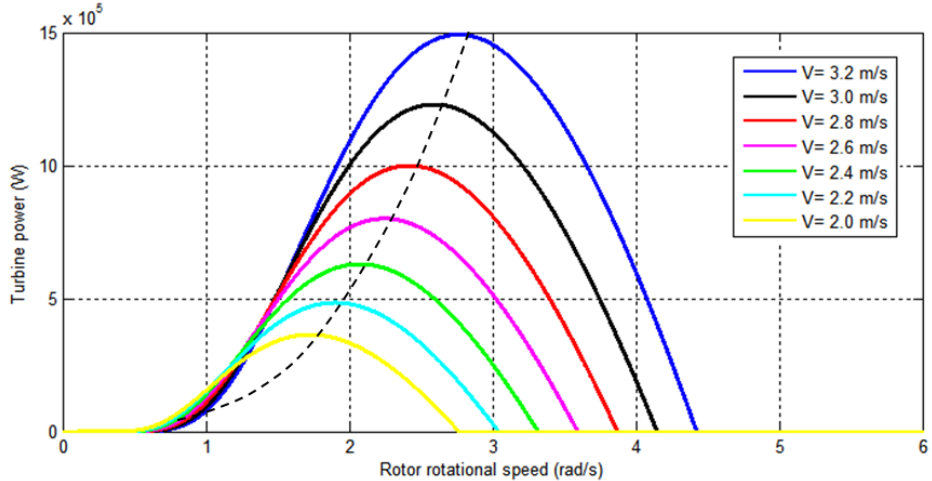
Figure 13. Extracted power as a function of the rotor speed for different tidal